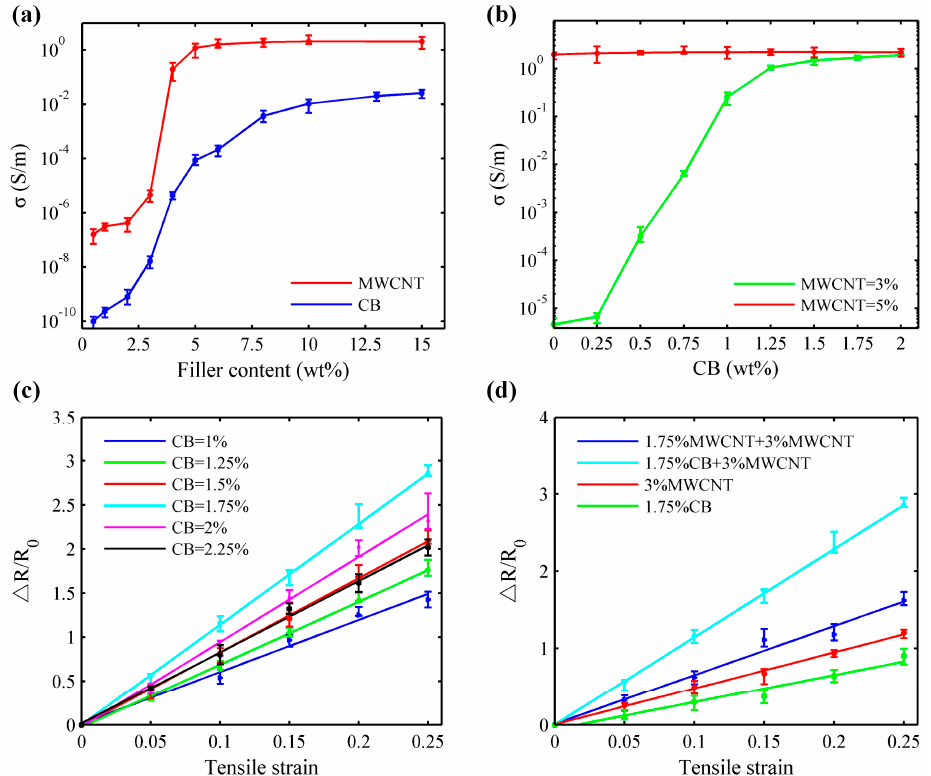
Figure 2. The electrical conductivity of nanocomposites with different fillers content and the results of resistance change ratio ( ∆ R / R 0 ) under varying tensile strain. ( a ) Conductivity of binary nanocomposites containing CB or MWCNT (inset: Amplified image of CB/PDMS nanocomposite conductivity); ( b ) Conductivity of ternary nanocomposites with variable CB contents when weight percentage of MWCNT was fixed as 3% and 5%, respectively; ( c ) The results of resistance change ratio with the fixed 3 wt % MWCNT and variable CB content under the applied tensile strain of up to 25%; ( d ) The function of resistance change ratio with the special combination of MWCNT and CB